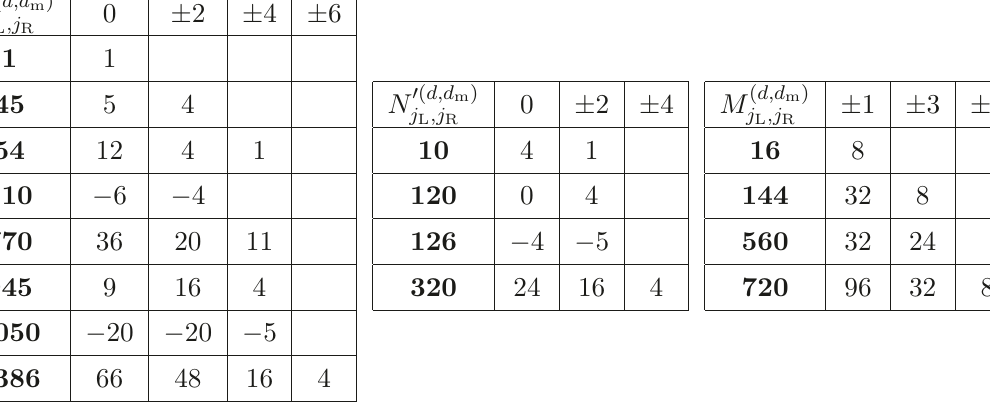
′ ( d,d m ) for the representations of so(10) j L ,j R ( k ) d for the representations of j L ,j R